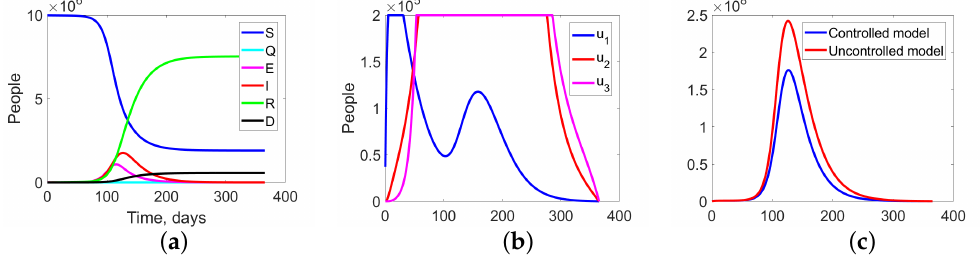
Figure 8. Experiment 1. ( a ) Sum of the fractions of all levels in controlled case; ( b ) the structure of the optimal treatment policies u i ( t ) , i = 1,2,3; ( c ) aggregation costs in uncontrolled and controlled